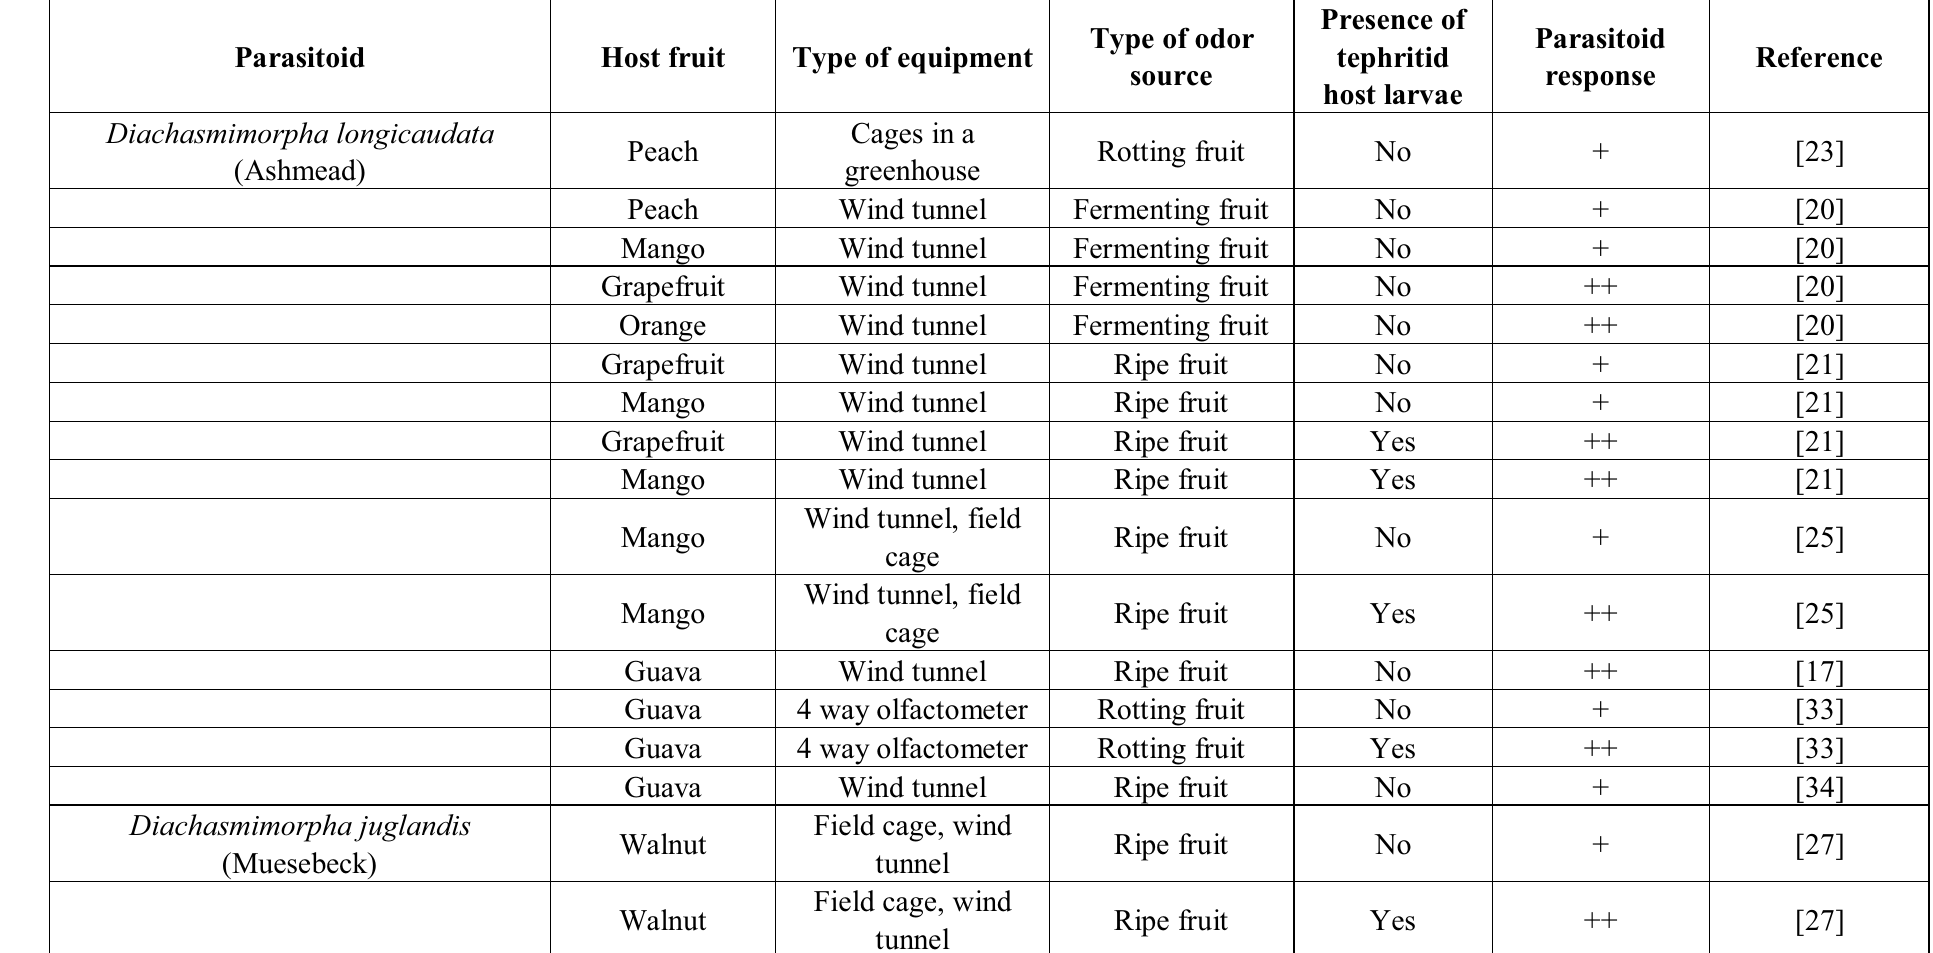
Table 1. The response of female parasitoids (Hymenoptera: Braconidae) to host-fruit (infested and uninfested) odors. + : moderate response; ++: strong